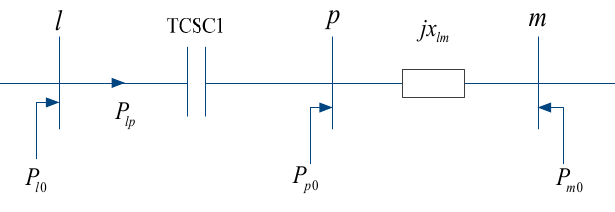
Figure 2. DC power flow model with TCSC1.